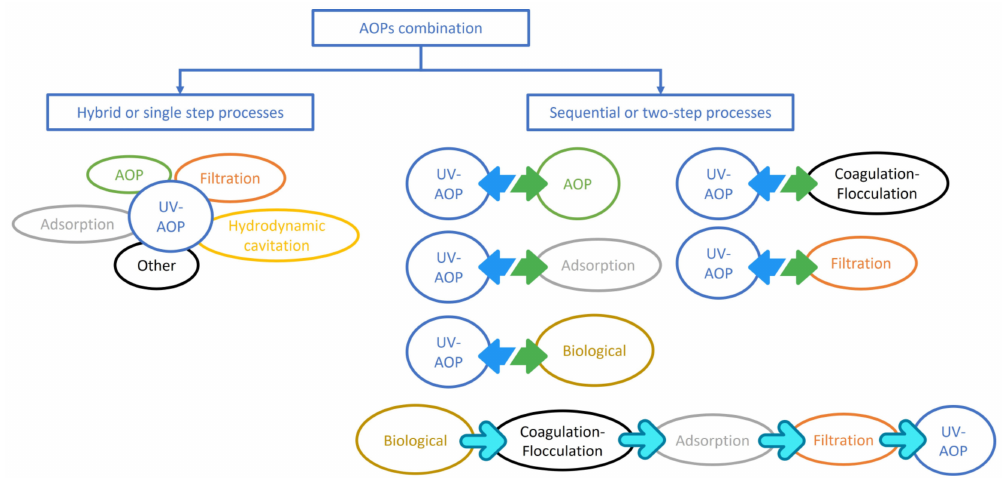
Figure 6. Possibilities of combining UV-AOPs in a single or sequenced